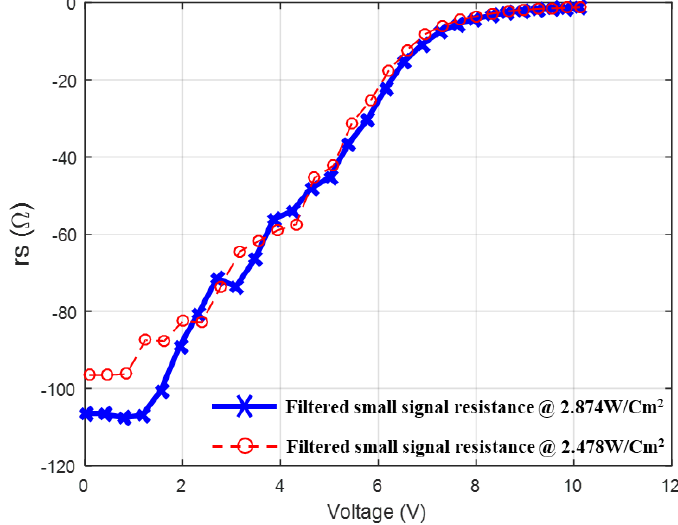
Figure 4. Small-signal resistance characteristics of laser PV module.